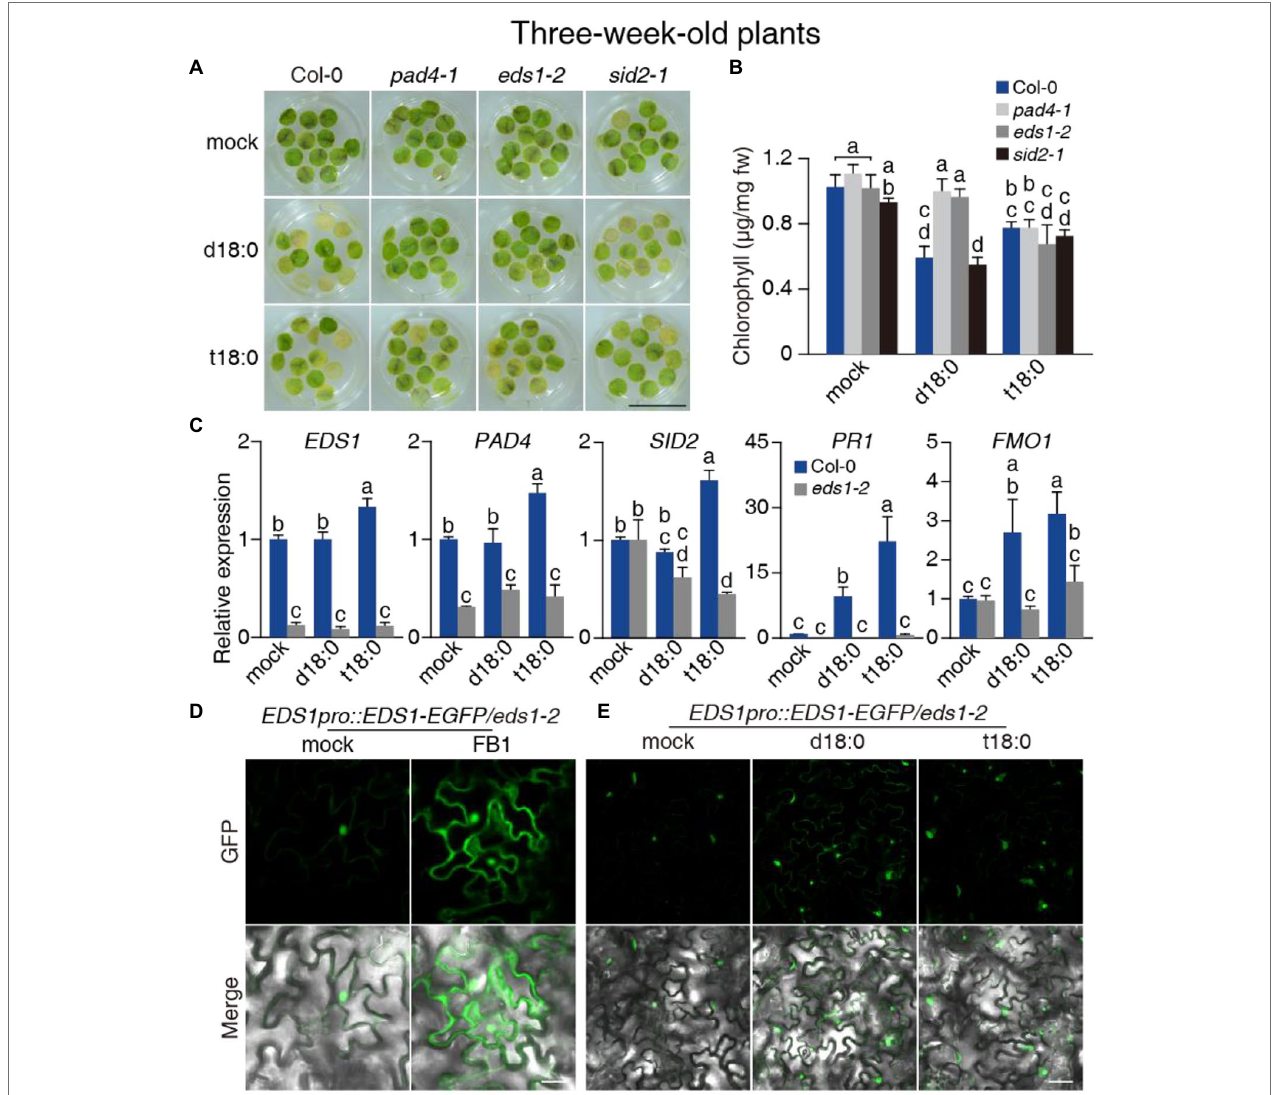
FIGURE 4 | Effect of the pad4-1 , eds1-2 , and sid2-1 mutations on LCB-induced cell death and immunity and the response of EDS1 protein to LCBs. (A) Representative images of detached leaf disks 5 days after 100 μ M LCBs (d18:0 or t18:0) treatment. At least 36 leaf disks per line were test each time. Bar = 1 cm. (B) Chlorophyll content 5 days after treatment from (A) . (C) Relative transcript levels for EDS1 , PAD4 , SID2 , PR1 , and FMO1 in 3-week-old plants 24 h after 0.5% ethanol (mock) treatment or treatment with 100 μ M d18:0 or t18:0. ACT2 served as the internal control. Values were normalized to Col-0 levels (set to 1). (D,E) EDS1 protein accumulated in FB1-treated (D) and LCB-treated (E) 3-week-old eds1-2 EDS1pro:EDS1-EGFP transgenic plants. A representative confocal live epidermal cell image was shown from at least 30 leaves per line. Bar = 20 μ m. Values are means ± SE from triplicate biological repeats in (B,C) . Different letters indicate significant differences between all genotypes/treatments, as determined by Fisher’s PLSD ( p < 0.05) in (B,C) . All experiments were conducted at least three times using independent